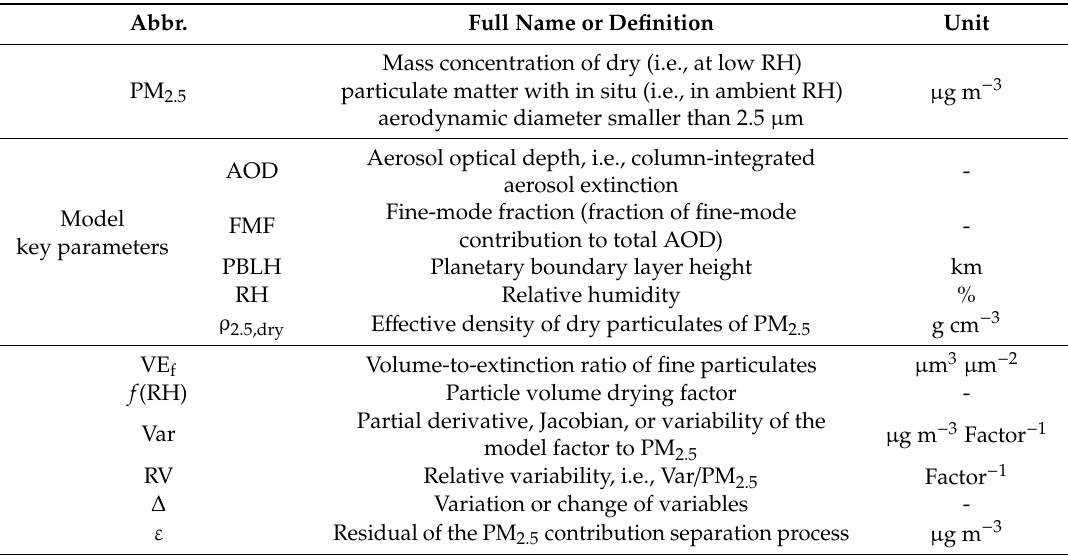
Table A1. Symbols, definition and units used in the paper.